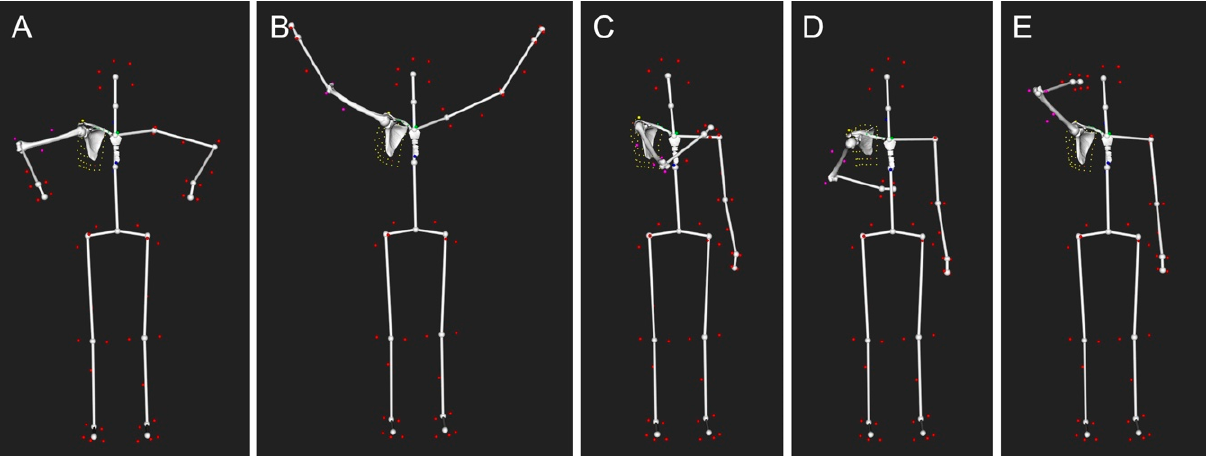
Figure 3. Examples of computed postures from motion capture (right shoulder): ( A ) maximum internal rotation with a 90 degree abduction and the elbow flexed 90 degrees (IR90 degrees); ( B ) maximum abduction in the scapular plane; ( C ) crossing arms; ( D ) hand behind back; ( E ) combing hair. The colored dots represent the retro-reflective skin markers. A virtual skeleton was also used to better visualize the global motion.